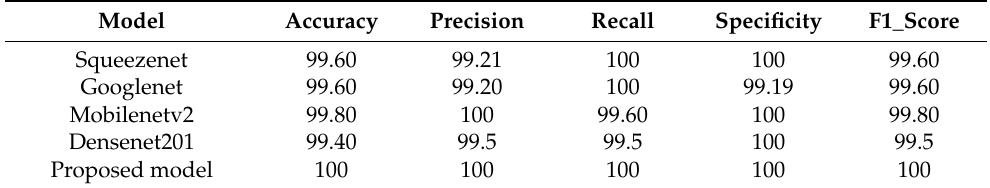
Table 14. COVID-19 binary classification using CT scan images comparison with state-of-the- art models. Model Accuracy Precision Recall Specificity F1_Score Squeezenet 99.60 99.21 Googlenet